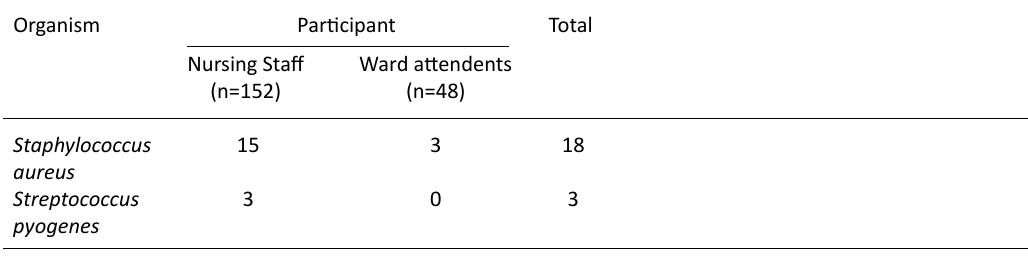
Table 1. Segregation of organisms isolated by swabbing method Organism